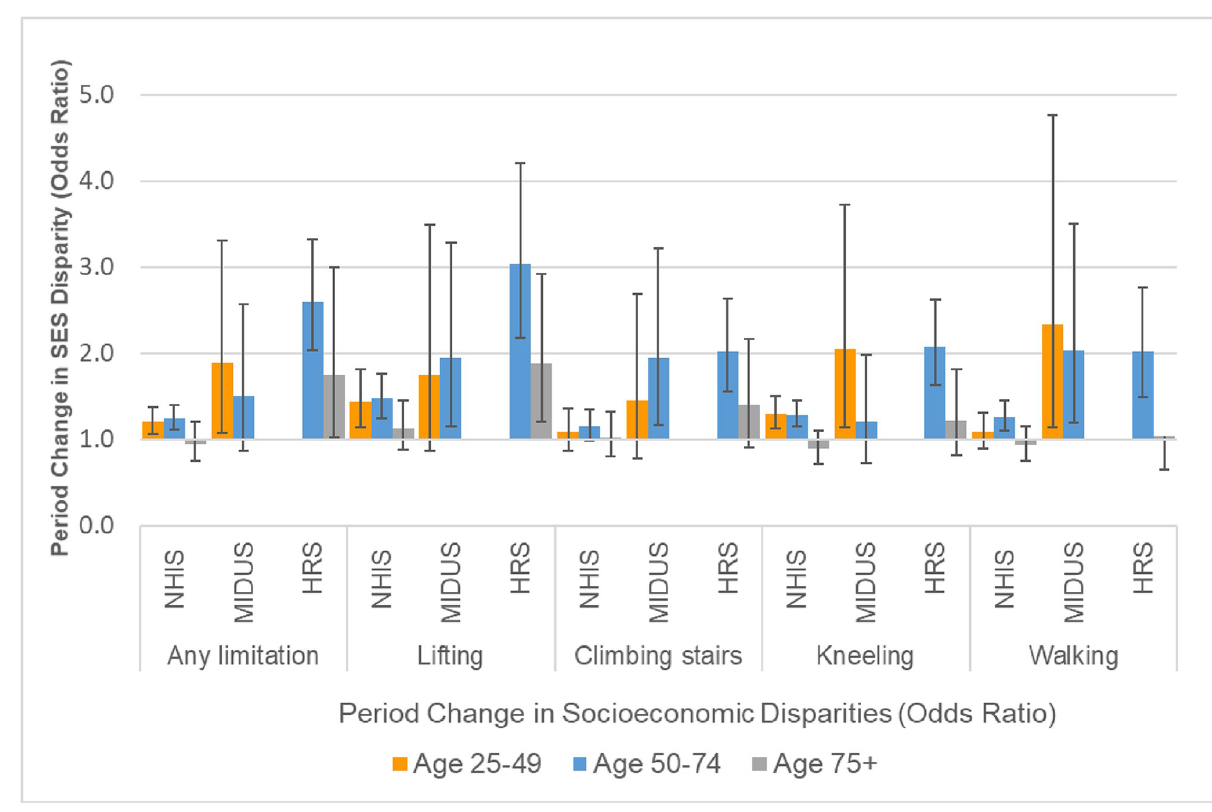
Fig 6. Changes over time in socioeconomic disparities in physical limitations by age group. The SES disparity was computed as the odds ratio for the 90 th versus the 10 th percentile of SES. The estimates were based on models fit separately for the three age groups. All models adjusted for sex, age (linear specification), race/ethnicity, period (categorical specification), and SES. The models also included the following 2-way interactions: age x period; age x SES; and period x